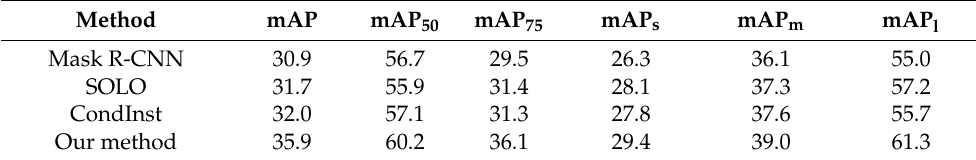
Table 3. The comparisons of numerous instance segmentation methods.